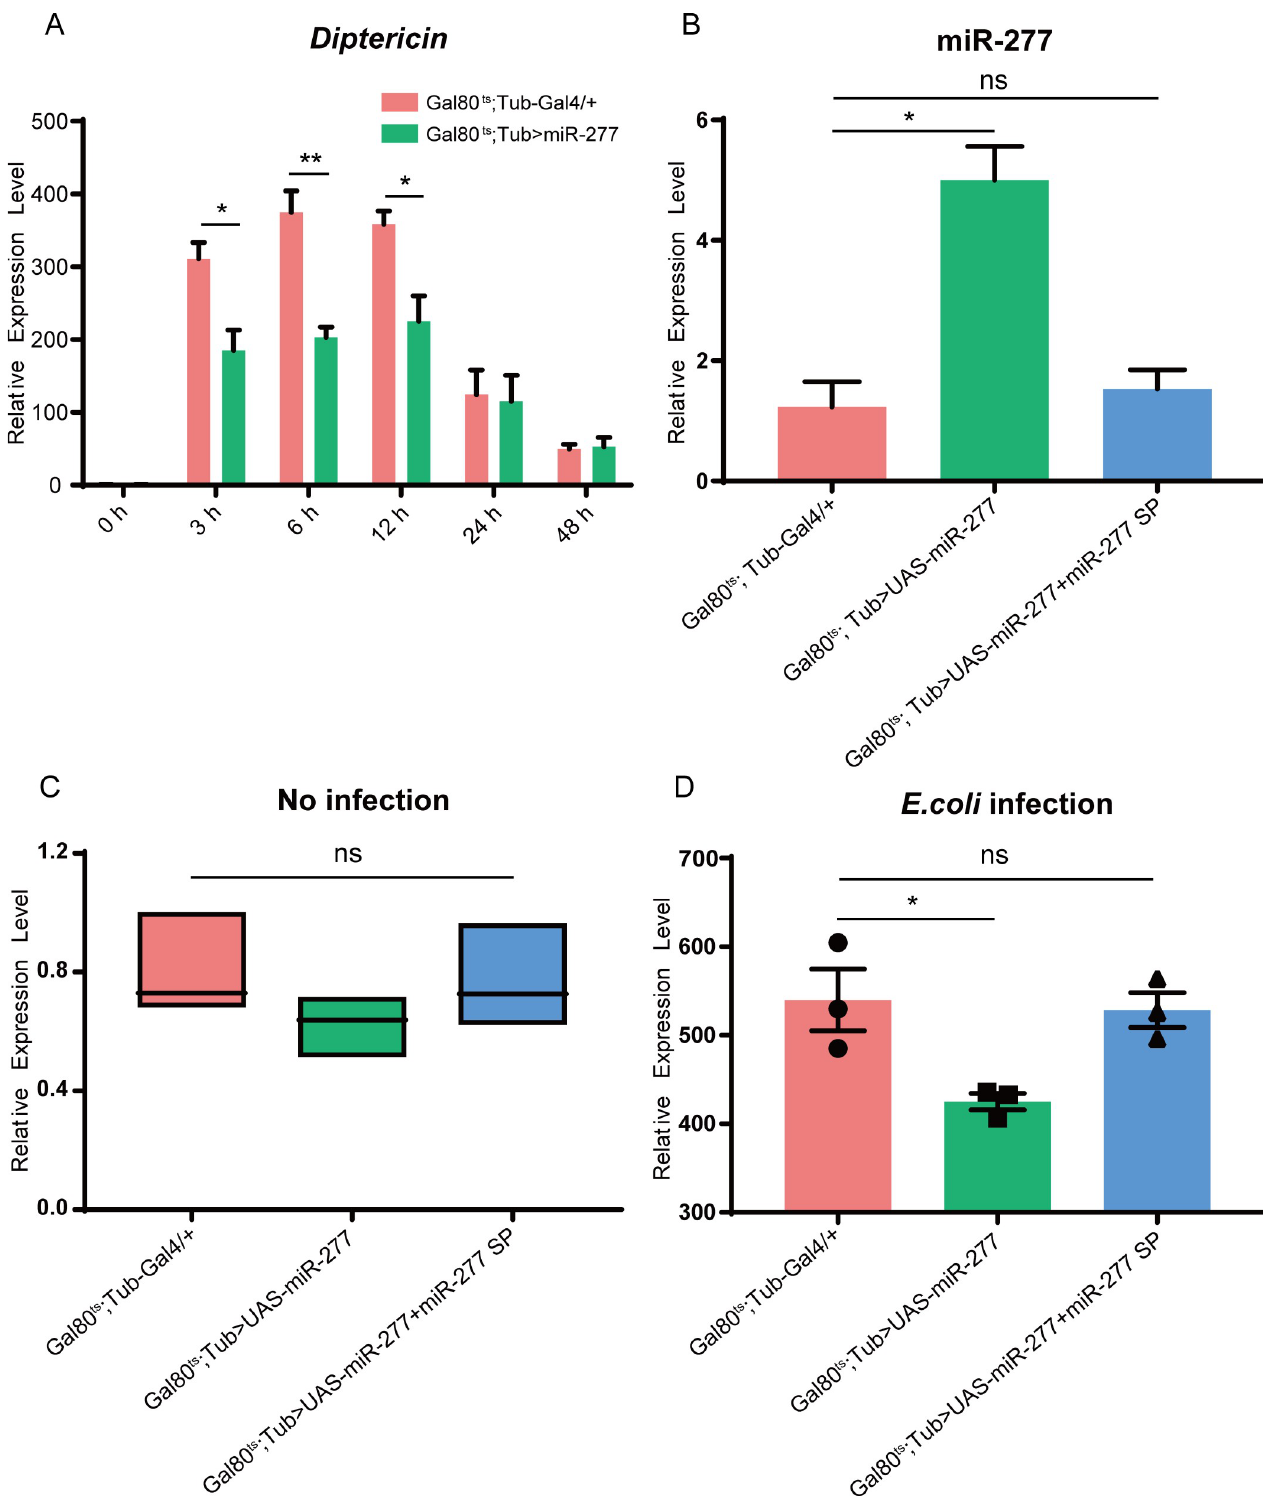
Fig 4. miR-277 negatively regulates Drosophila Imd pathway immune response. (A) The expression level of Dpt was detected in miR-277 highexpressed fly strains ( Gal80 ts ; Tub > miR-277 ) at 0, 3, 6, 12, 24 and 48 h upon E . coli infection. (B) The expression level of miR-277 was measured in the control flies, this miR- 277 highrexpressed flies, and this miR-277 and miR-277 sponge co-highexpressed flies before E . coli infection. The transcriptional level of Dpt was determined before (C) and after (D) E . coli infection.